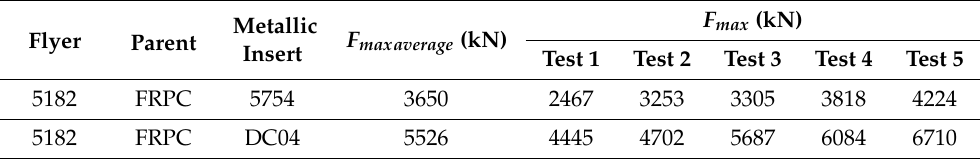
Table 7. Dynamic lap-shear tests for metallic insert configuration (E = 16 kJ).